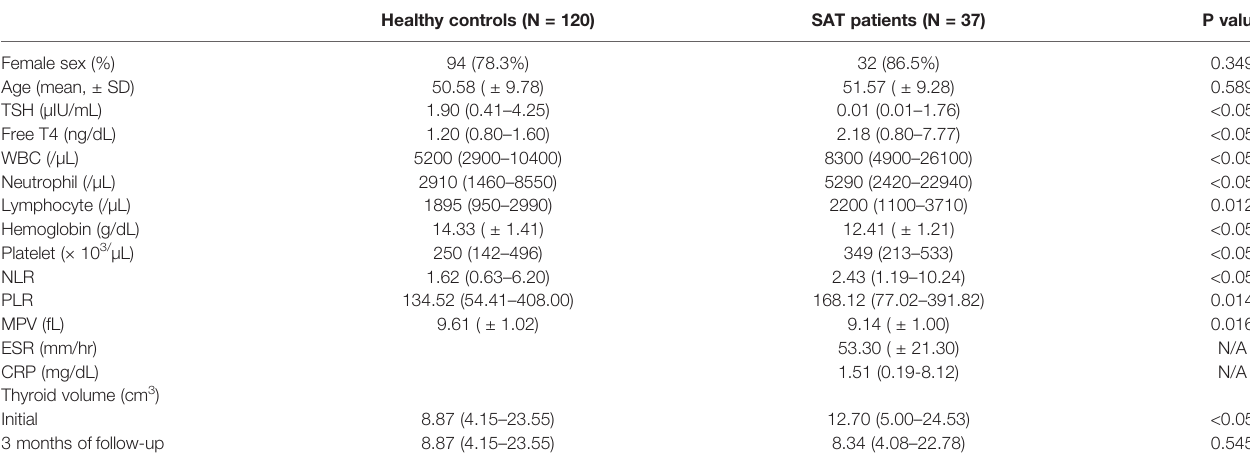
TABLE 1 | Baseline demographic and clinical